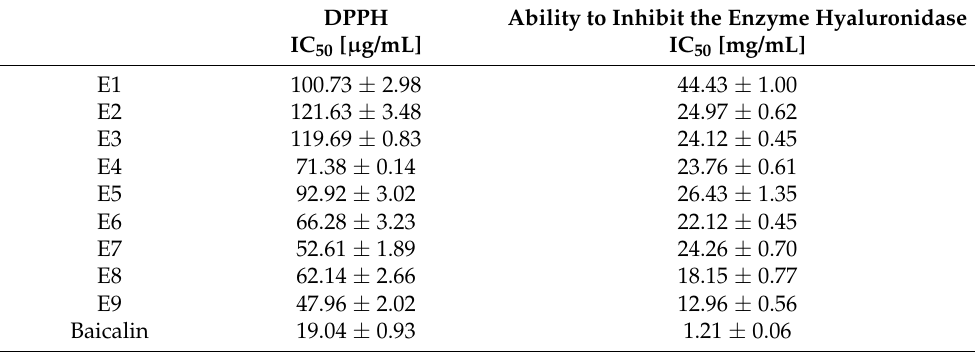
Table 4. Antioxidant and anti-hyaluronidase activities of S. baicalensis radix extracts.